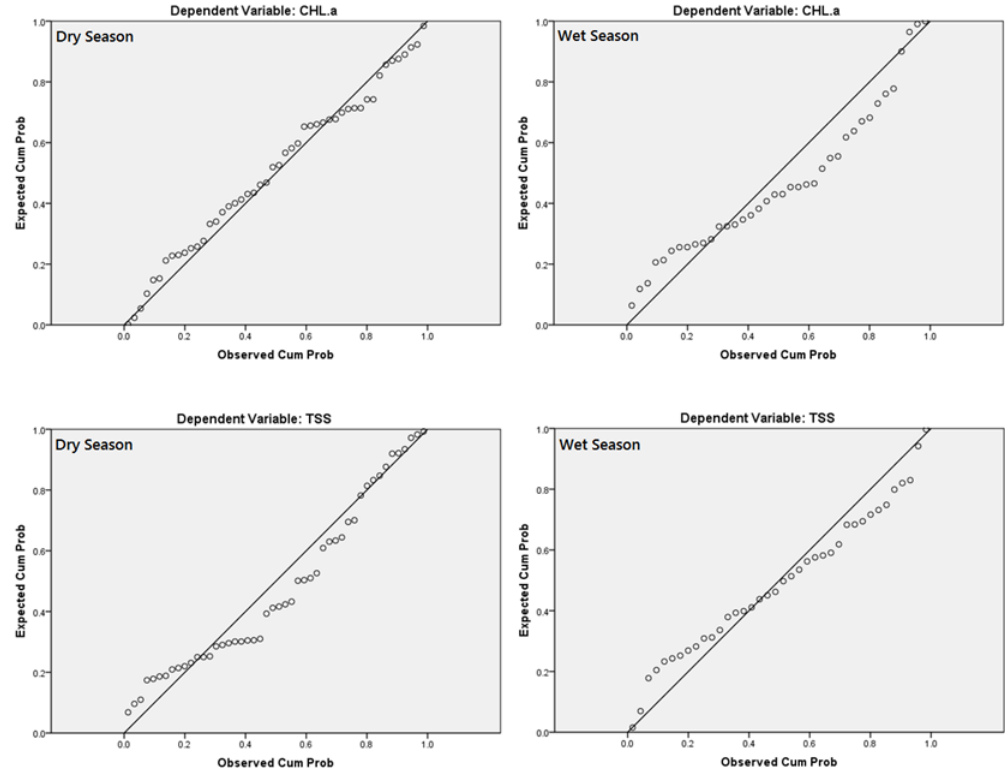
Figure 3. The normal probability-probability (P-P) plots of regression standardized residuals for total phosphate and Chl-a and TSS in wet and dry seasons. Table 5. Pearson’s R correlation for the in-situ water quality parameters and Landsat bands and ratios.